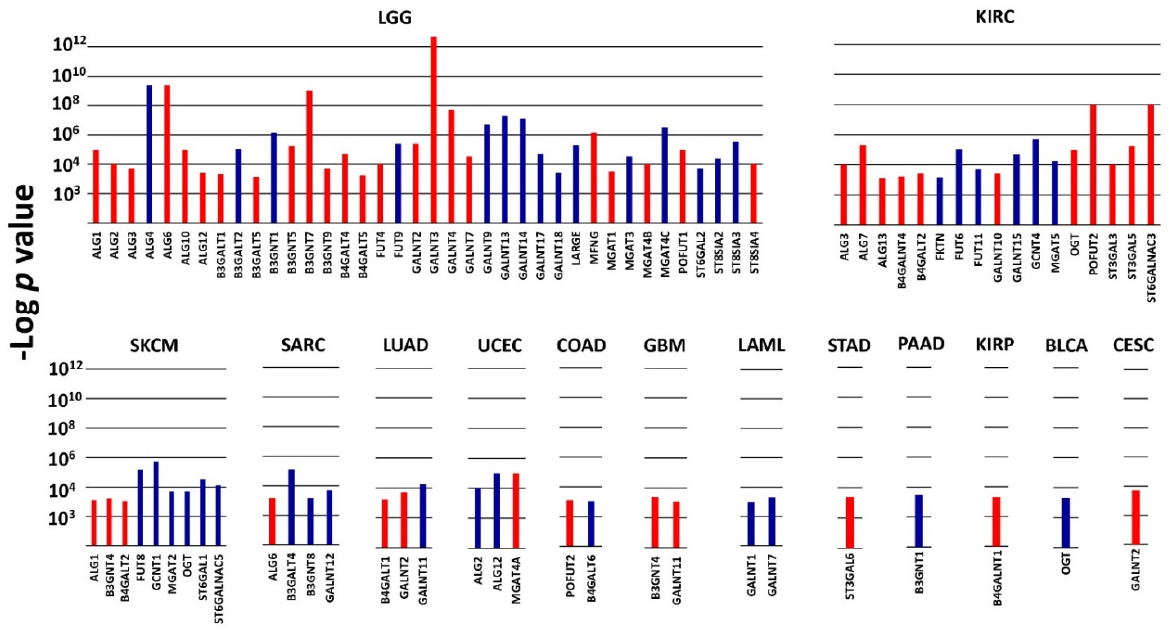
Figure 1. VHPV in TCGA cohorts. Histograms represent the − Log of the p value for the comparison between the overall survival curves of the 15% higher expressers of each glycosyltransferase gene and the 15% lower expressers. Color labels indicate the association with a bad (red) or good (blue) prognosis. p < 1 × 10 − 3 was arbitrarily set as the threshold limit for inclusion. Cohorts not present in the figure did not contain any VHPV